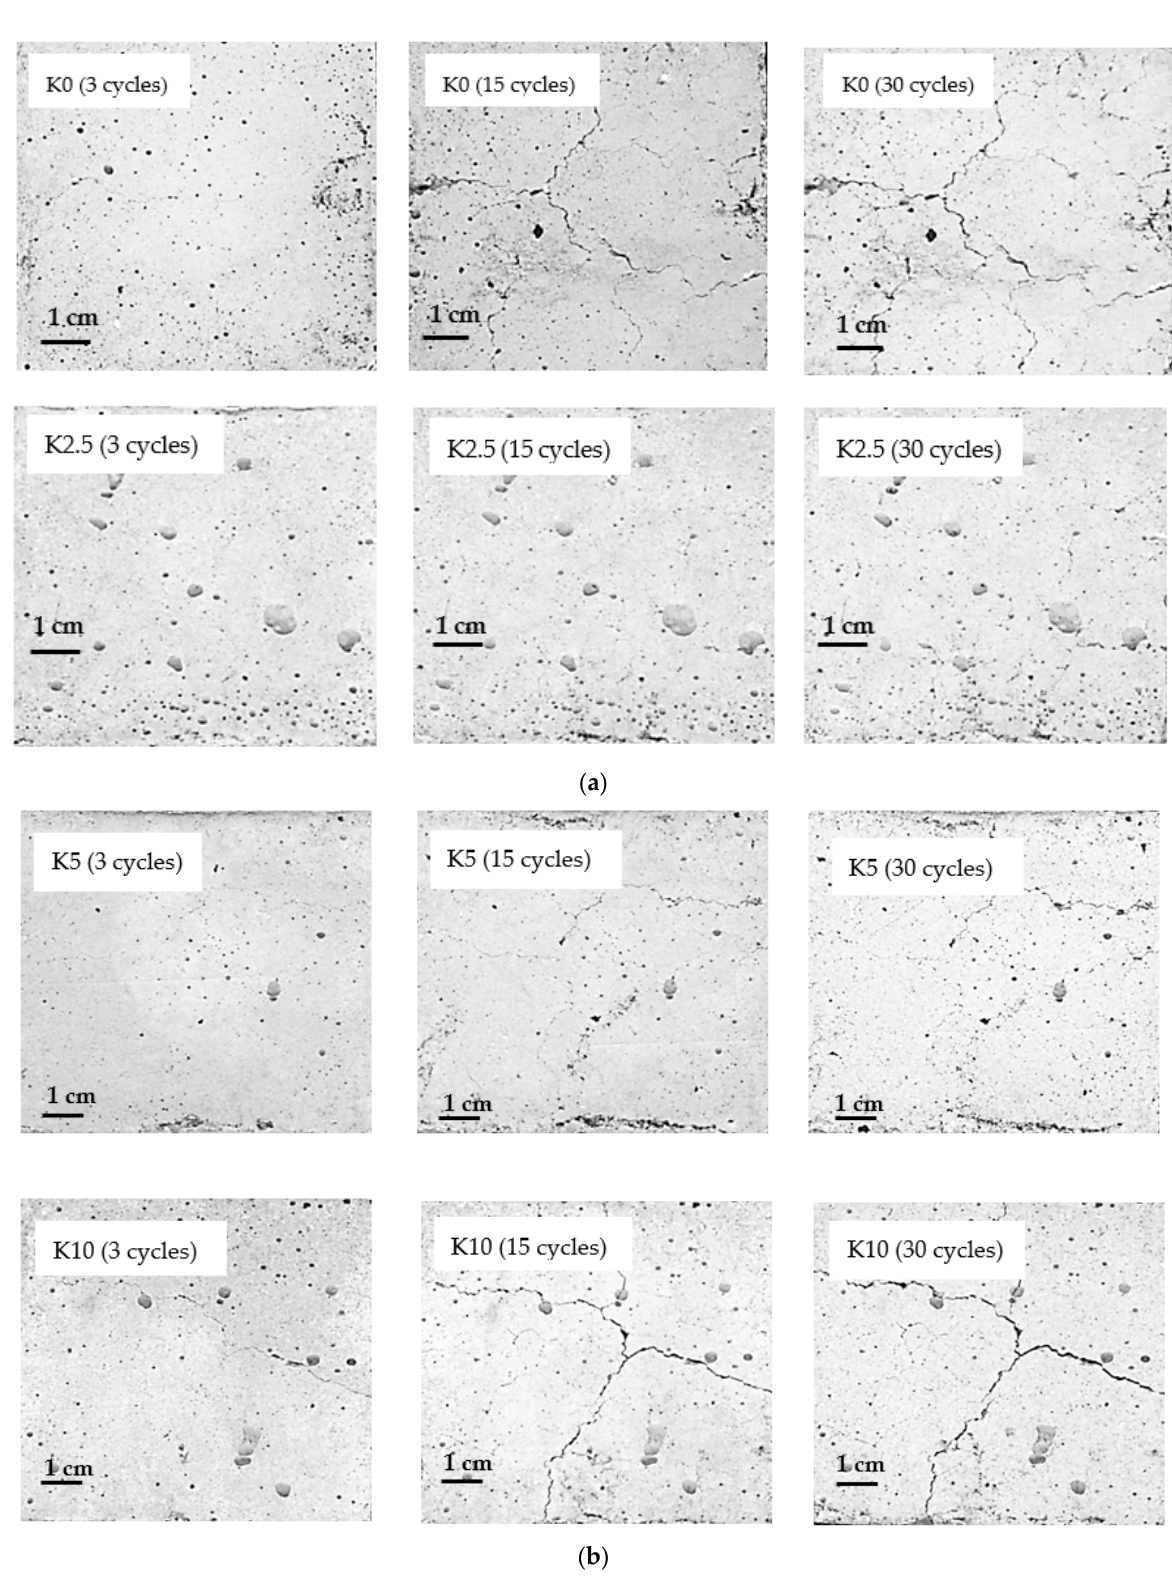
Figure 4. ( a ) Surfaces of castable specimens K0 and K2.5 after 3, 15, and 30 thermal cycles. ( b ) Surfaces of castable specimens K5 and K10 after 3, 15, and 30 thermal cycles.